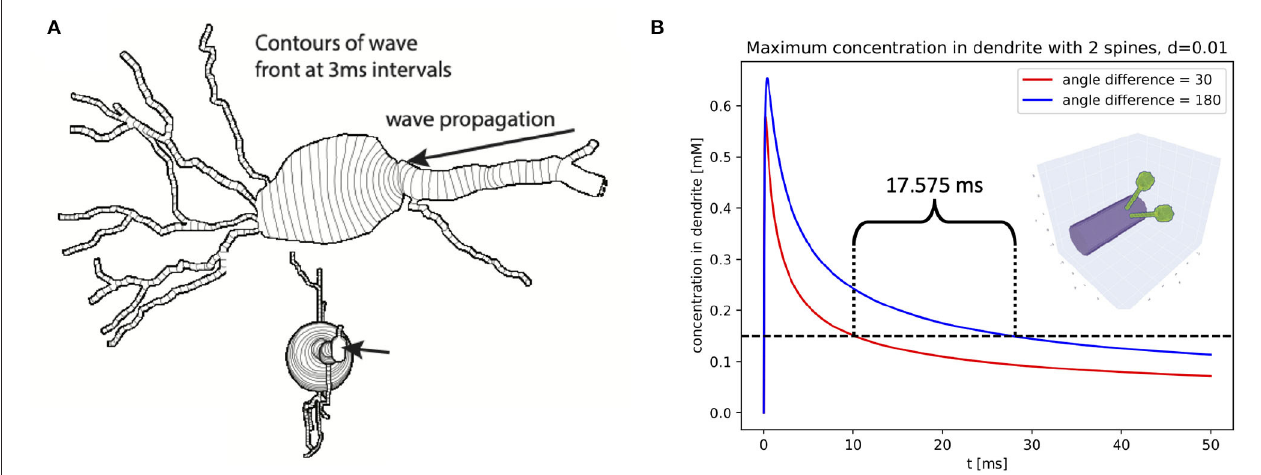
FIGURE 12 | Chemical concentration within neurons is affected by the 3D shape of the cell. (A) An intracellular wave entering the soma may curve, slow, and in extreme cases fail to propagate. (B) Diffusion of ligand from neighboring spines (red; illustrated as inset) leads to different trajectories of higher peak dendrite concentrations than from spines opposite each other on the